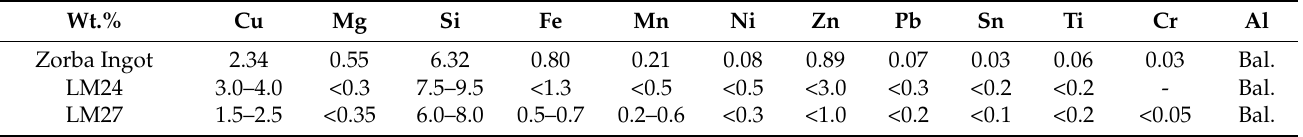
Table 1. Chemical composition of the aluminum alloy recovered from Zorba cast fraction compared with some typical commercial cast alloys.